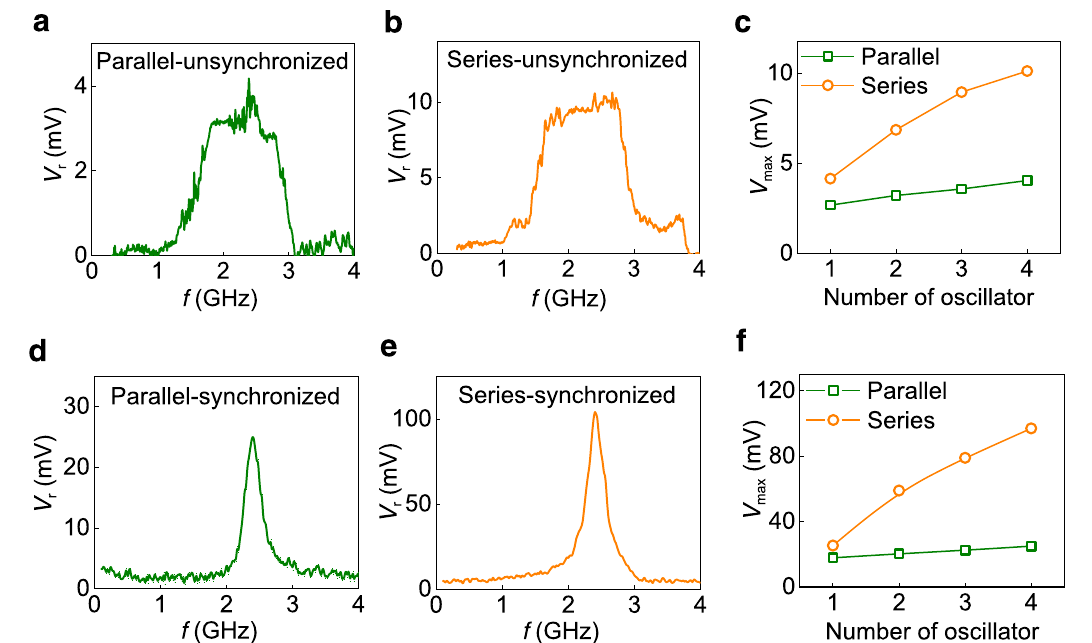
Fig. 5 Voltage recti fi cation with four unsynchronized and synchronized oscillators. a , b Zero dc bias recti fi cation at P rf = − 10 dBm in parallel at a magnetic fi eld of 180 Oe and series connections at a magnetic fi eld of 150 Oe, respectively. c Enhancement in the recti fi ed voltage at 2.4 GHz with increasing the number of oscillators at zero dc bias and P rf = − 10 dBm. d , e Recti fi cation results of four synchronized oscillators at P rf = − 10 dBm in parallel ( d ) at I dc = 3.4 mA and H = 140 Oe and in series ( e ) at I dc = 1.3 mA and H = 110 Oe. f Enhancement of the recti fi ed voltage at 2.4 GHz with increasing the number of oscillators synchronized with dc